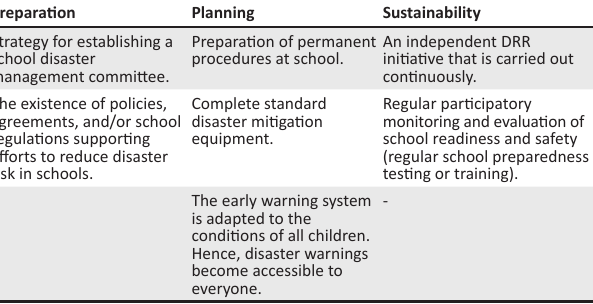
TABLE 2: School management awareness and strategies for conducting disaster risk reduction.